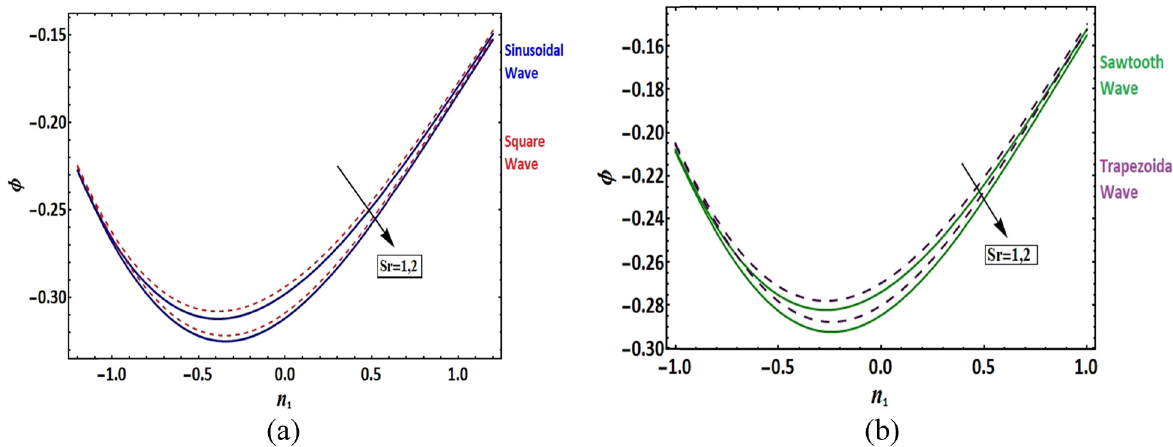
= 0.1, A = 2, Sc = 0.5, A 1 1